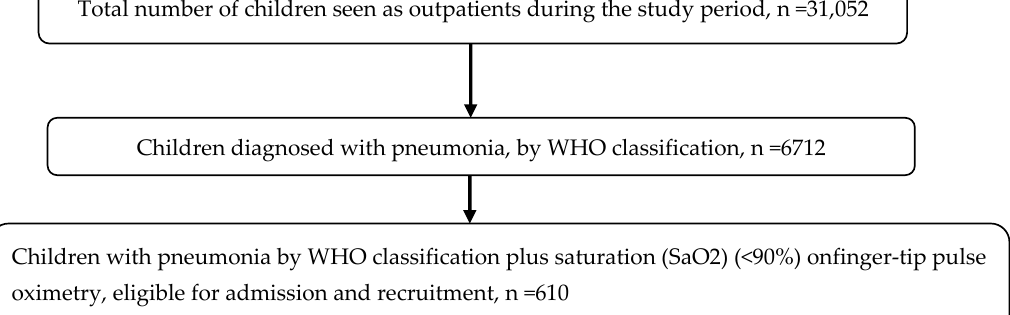
Children with pneumonia by WHO classification plus saturation (SaO2) (<90%) onfinger-tip pulse oximetry, eligible for admission and recruitment, n =610